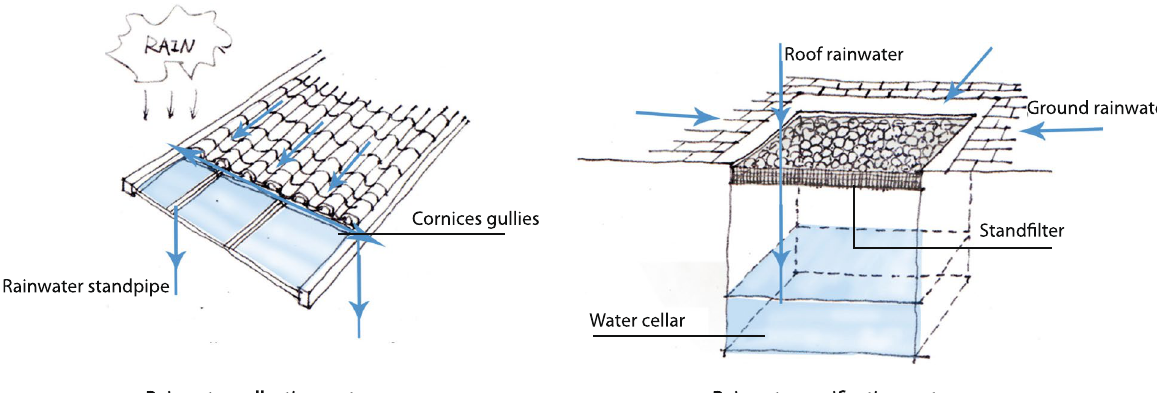
Fig. 22 Rainwater collection system for traditional residential buildings (Source: Tongji University and Ecole de Chaillot